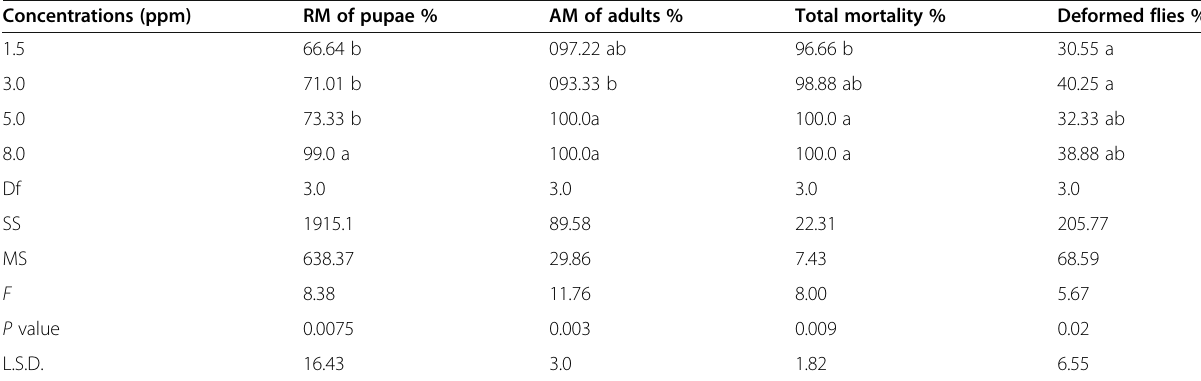
Table 3 The real and apparent mortalities, and deformed flies percentages of the peach fruit fly, Bactrocera zonata , treated with imidacloprid pesticide in pupal stage Concentrations